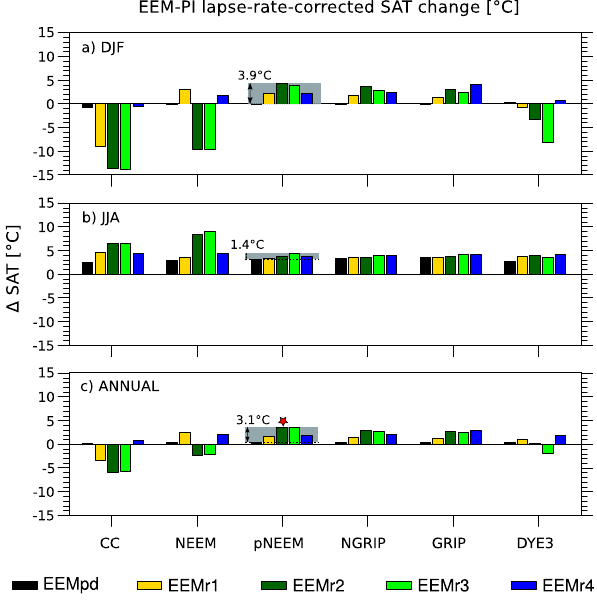
Figure 11. Eemian lapse-rate-corrected SAT anomalies ( ◦ C) with respect to pre-industrial (PI) for (a) DJF, (b) JJA, and (c) annual mean at Camp Century (CC), NEEM, pNEEM, NGRIP, GRIP, and DYE3. The gray bars in the pNEEM row indicate the spread among the EEM simulations, whereas the red star indicates the δ 15 N SAT estimate from NEEM community members